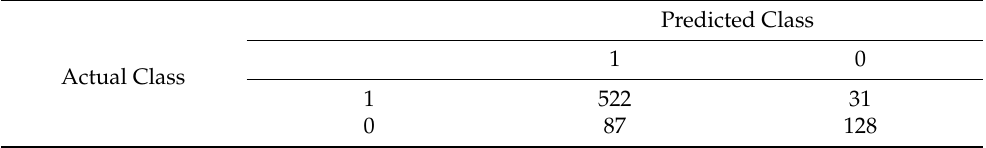
Table 8. Confusion matrix of